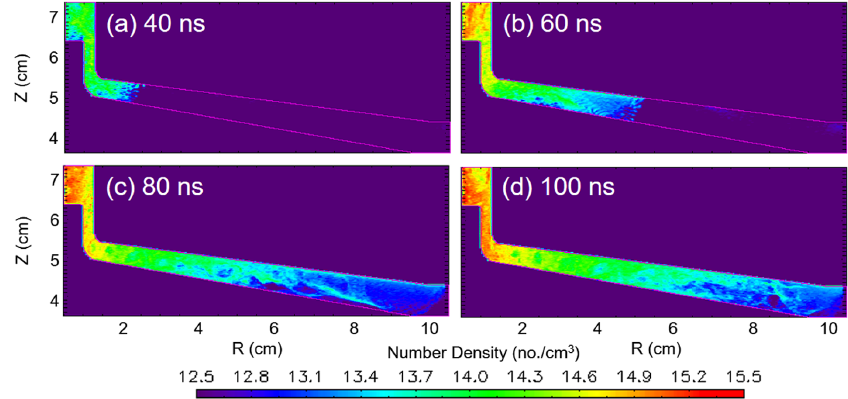
FIG. 7. For the p ¼ 0 Torr simulation, the ion density is plotted at (a) 40, (b) 60, (c) 80, and (d) 100 ns. Electron space charge limited emission allows for field stress E ¼ 200 kV = cm. Ions H þ and O þ SCL emission allowed after surface heats to 700 K.